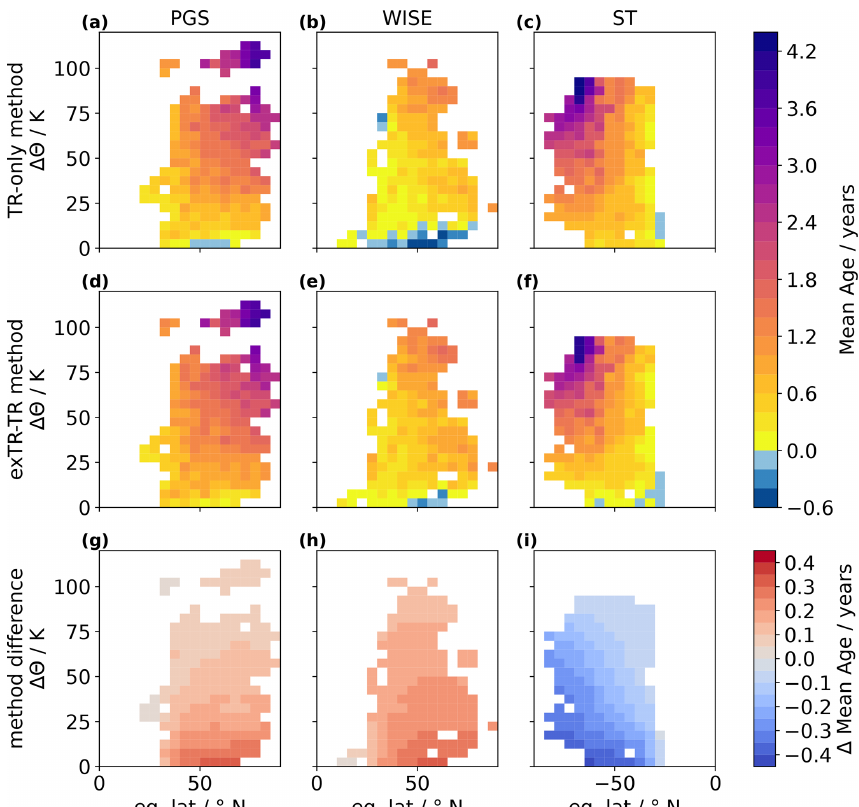
Figure 3. Comparison of methods to derive mean age in the LMS during PGS (a, d, g) , WISE (b, e, h) and SouthTRAC (c, f, i) . Results are shown for the TR-only method (a–c) and the new exTR–TR method (d–f) . The absolute differences between both methods are shown in (g) – (i) . Altitude is given in (cid:49)θ . Horizontally, data are sorted by eq. lat.